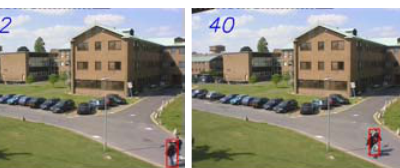
Fig. 6. Object detection and tracking.